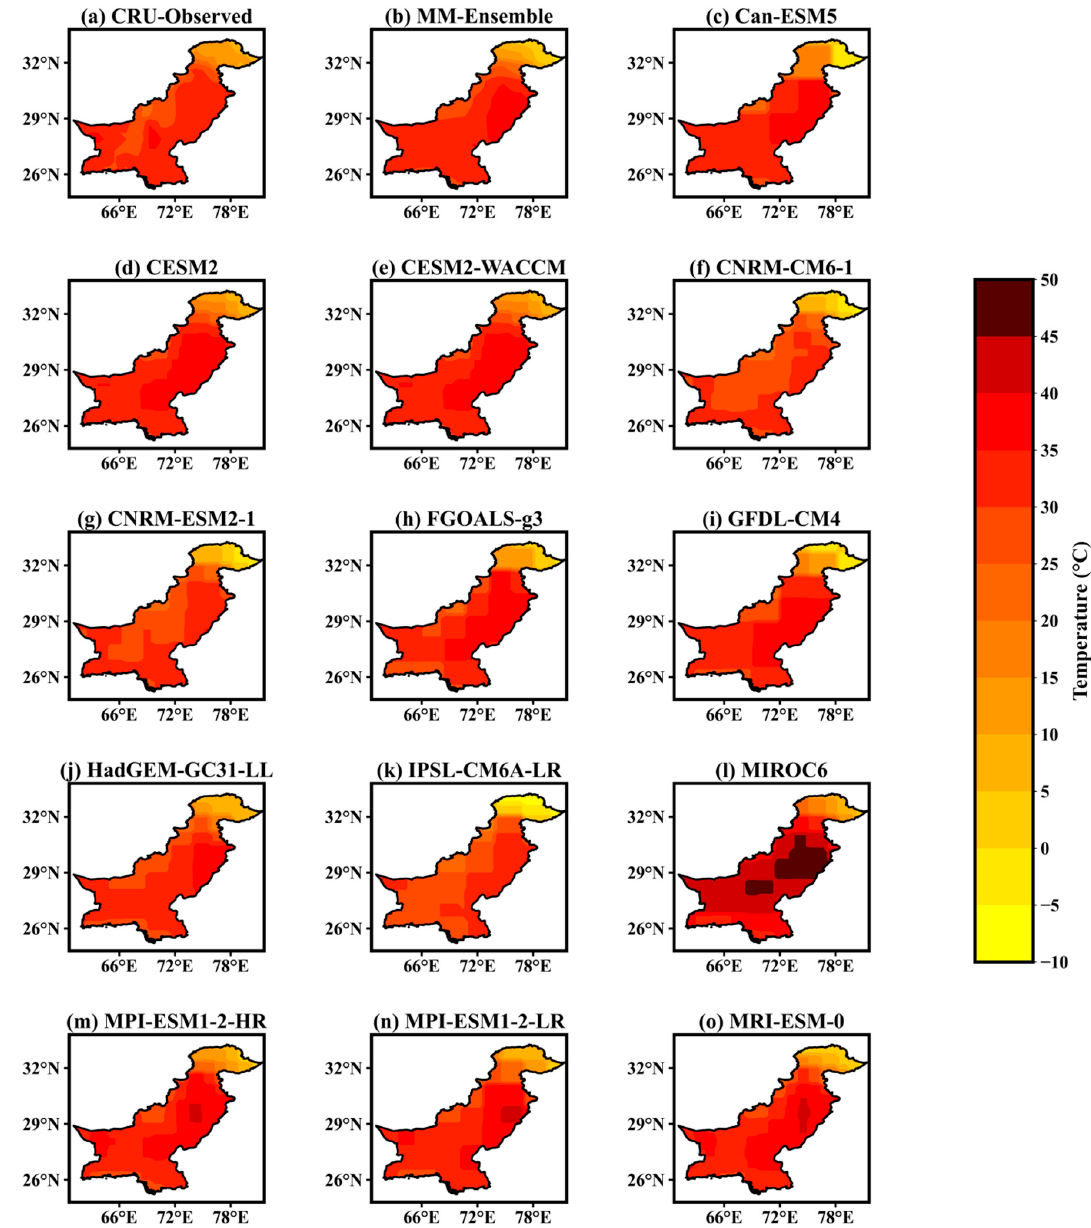
Figure 3. Spatial distribution of June–July–August (JJA) mean temperature (°C) over Pakistan for 1970–2014 for ( a ) CRU, ( b ) MM-Ensemble, ( c ) Can-ESM5, ( d ) CESM2, ( e ) CESM-WACCM, ( f ) CNRM-CM6-1, ( g ) CNRM-ESM2-1, ( h ) FGOALS-g3, ( i ) GFDL-CM4, ( j ) HadGEM-GC31-LL, ( k ) IPSL-CM6A-LR, ( l ) MIROC6, ( m ) MPI-ESM1-2-HR, ( n ) MPI-ESM-2-LR, and ( o ) MRI-ESM-0.